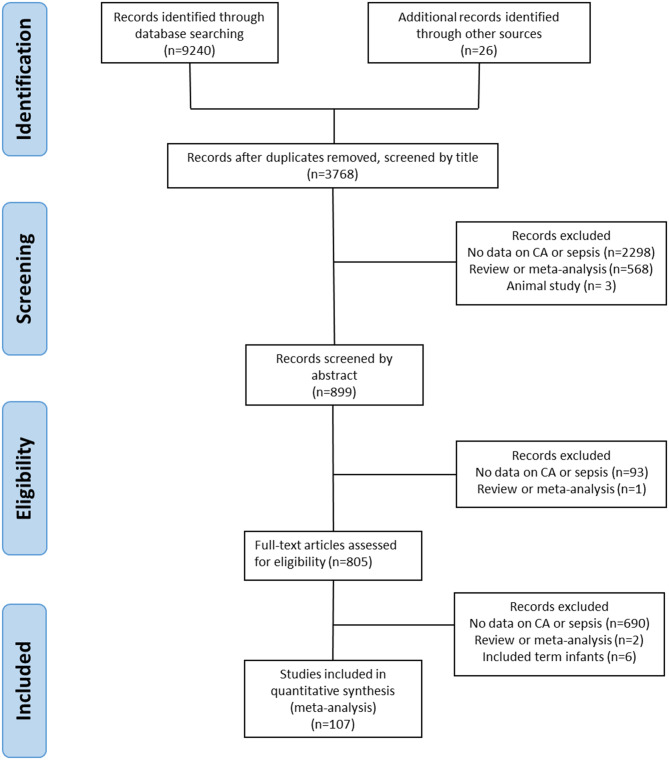
PRISMA diagram of the systematic search.